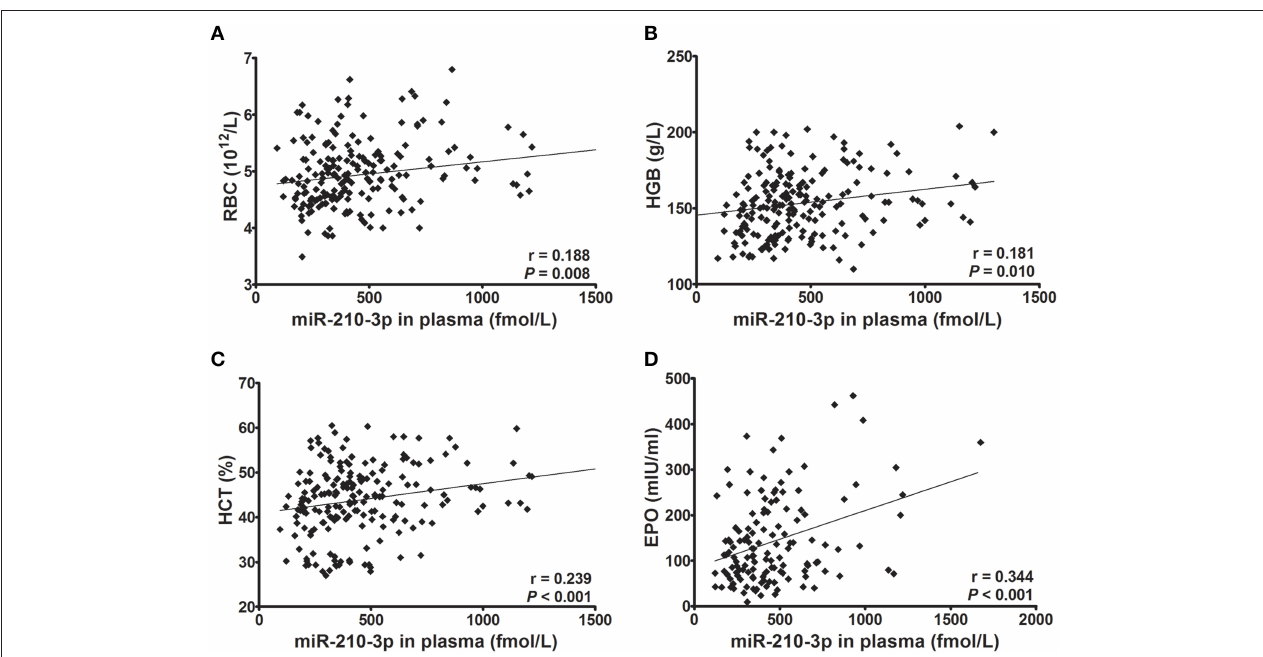
FIGURE 2 | The correlations of absolute concentrations of plasma miR-210-3p with hematological indices and plasma EPO concentrations ( n = 212 ). (A–D) Correlations of plasma miR-210-3p concentrations with red blood cell count (RBC) and with hemoglobin (HGB), hematocrit (HCT), and plasma erythropoietin (EPO) values, calculated by Spearman’s rank correlation analysis.